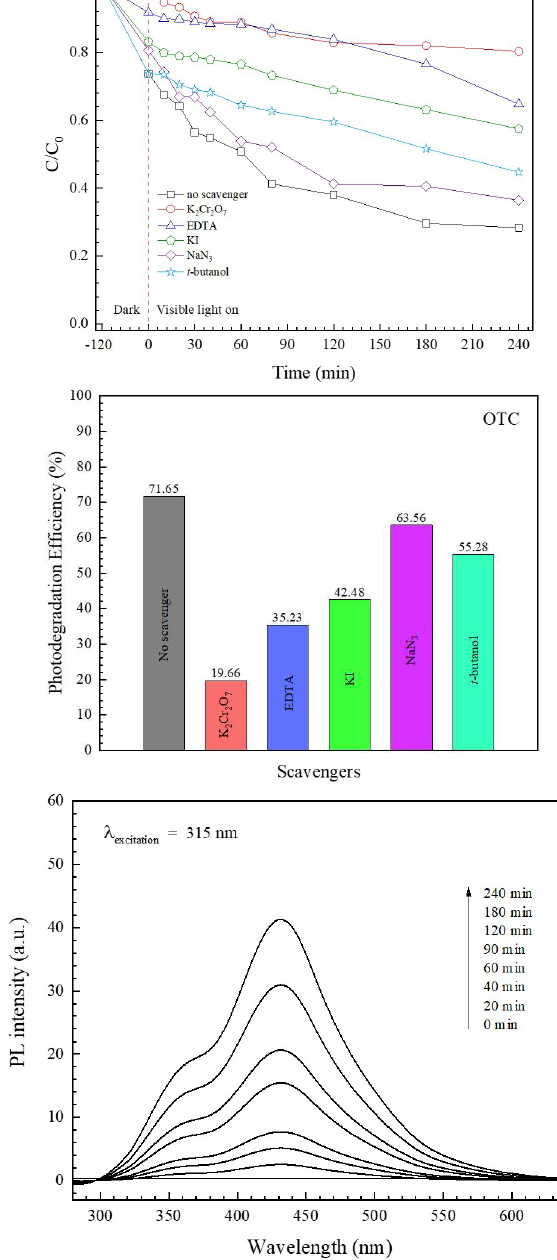
Figure 9. Trapping experiment from photodegradation of OTC ( a ), the corresponding photodegra- dation efficiency ( b ), and the hydroxyl radical trapping PL spectra of BiVO 4 after visible light illu- mination ( c ).